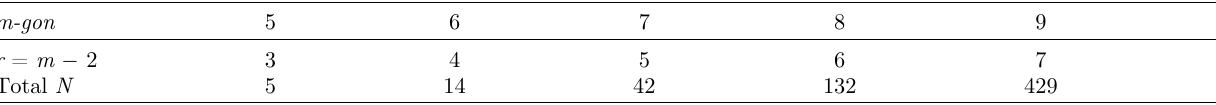
Table 8. Possible cuts for m -gons.